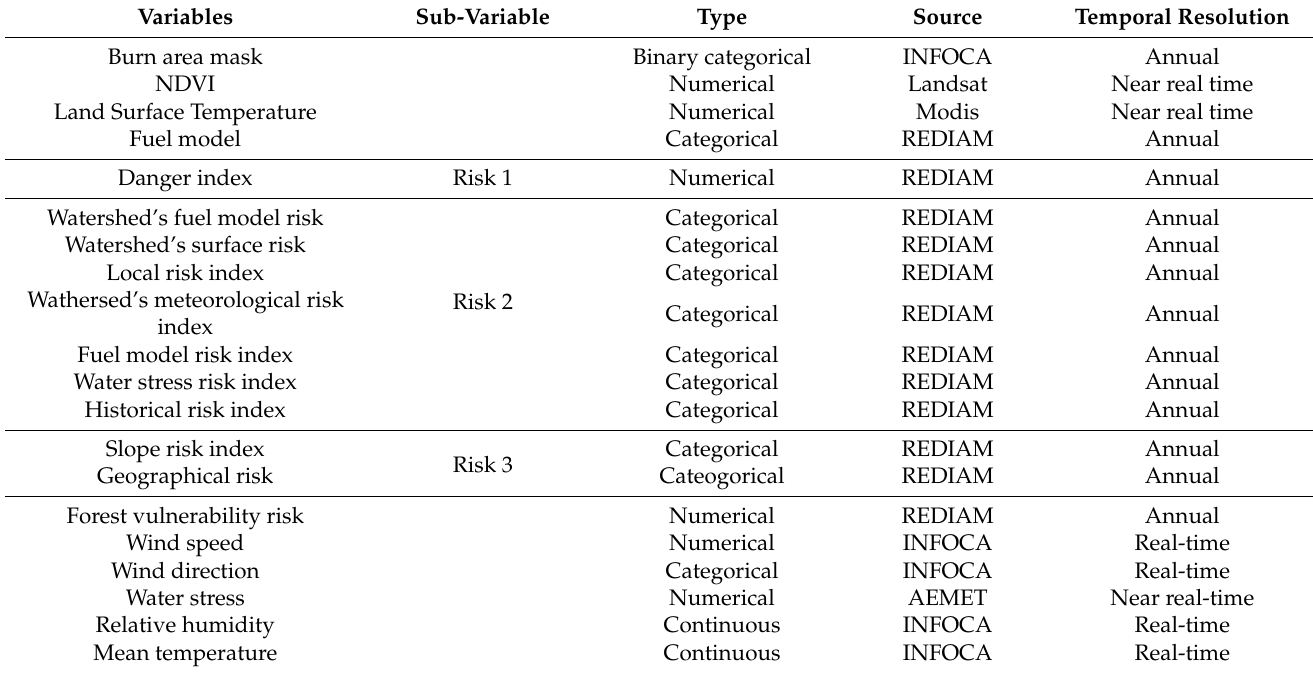
Table 1. Variables analyzed in the prediction of the occurrence of a large